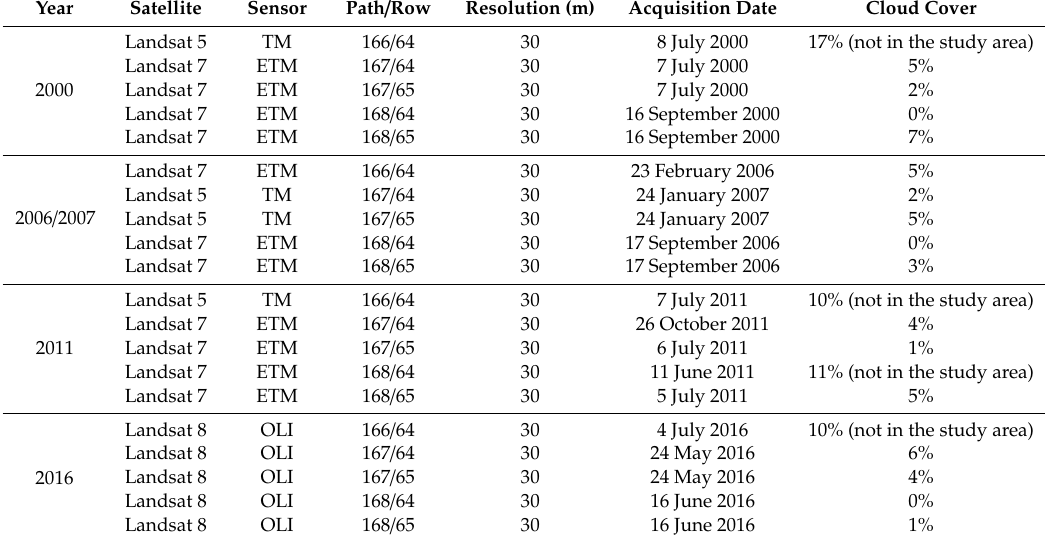
Table 1. Detailed data on Landsat images used in the study.